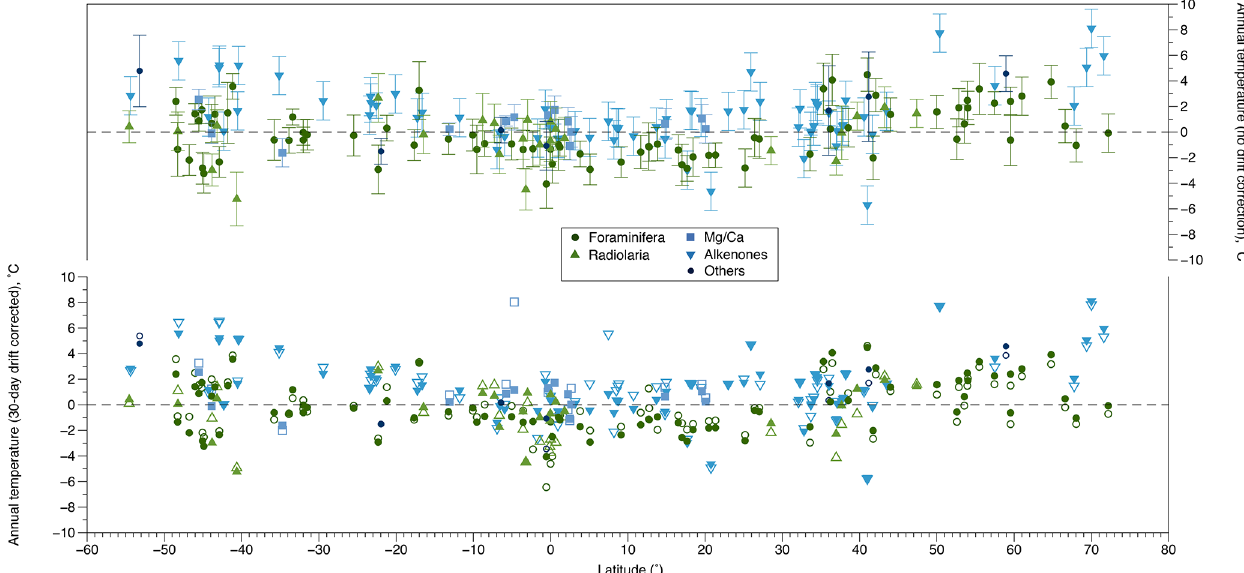
Figure 4. Quality control plot of latitudinal distribution of proxy mean annual Last Interglacial sea surface temperature anomalies. Estimates given relative to the modern period (1981–2010) (Rayner et al., 2003) with no drift correction (upper panel) and 30d drift (lower panel). The lower panel shows drift-corrected SSTs as open symbols with the uncorrected SSTs given as filled symbols. Uncertainties in the upper panel given at 1 σ